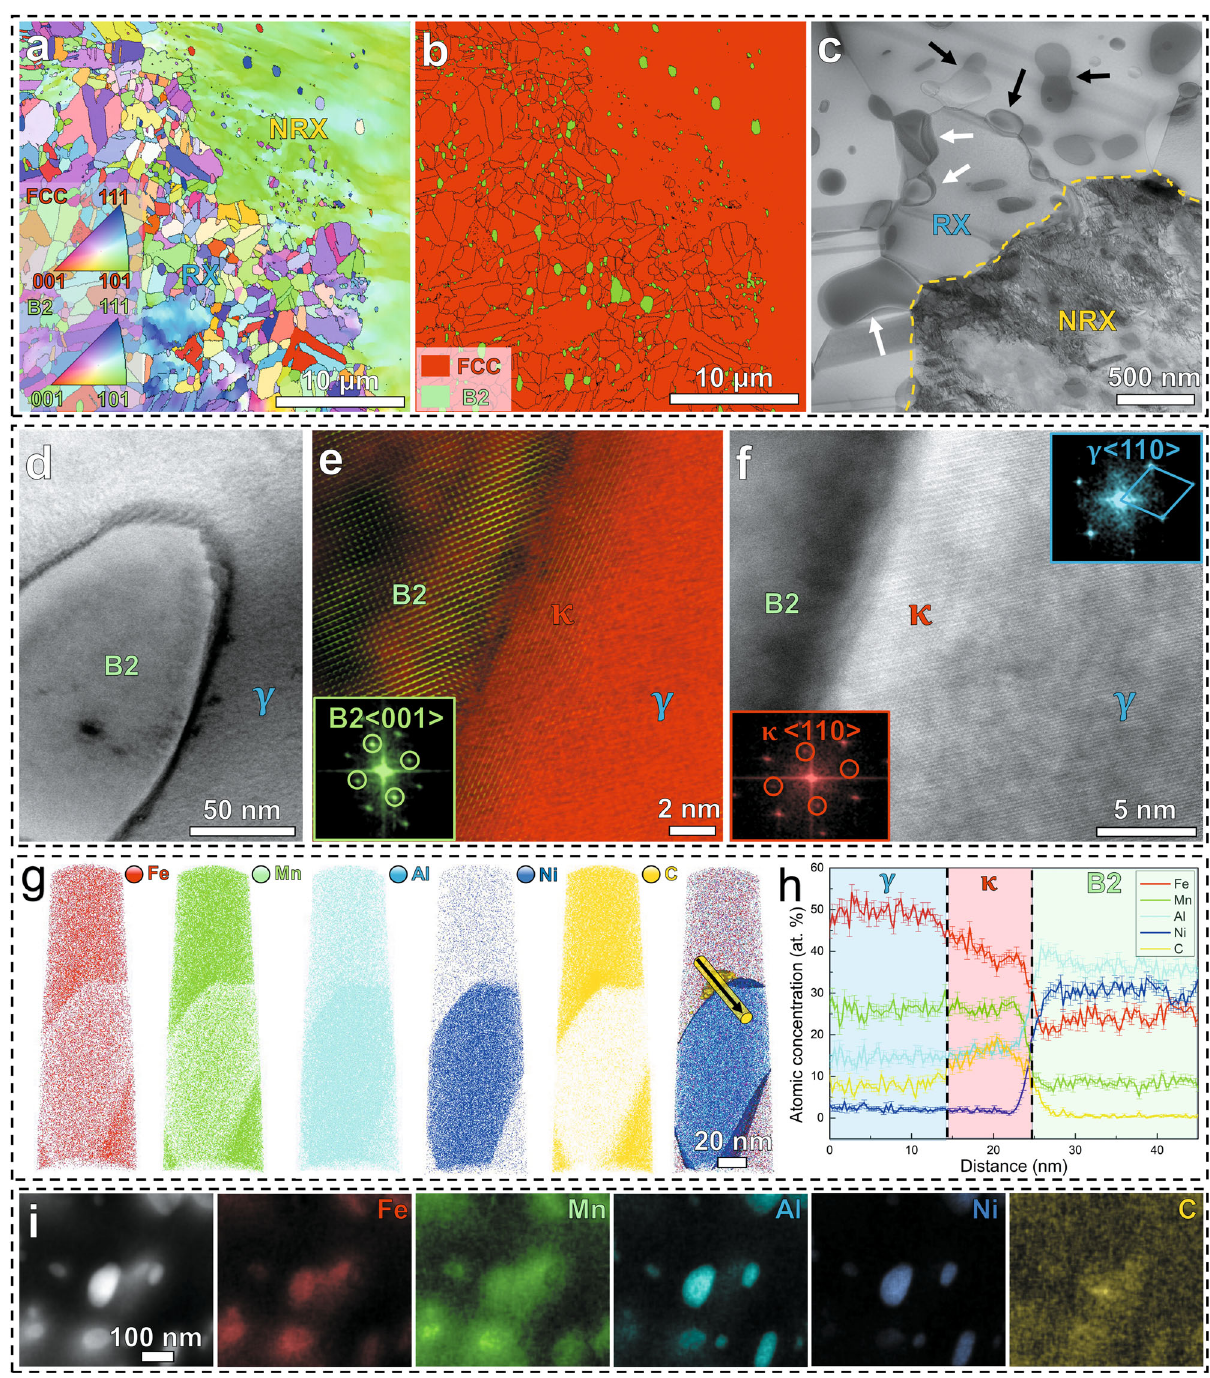
Fig. 1 Microstructures of the CCS. a EBSD IPF map. b EBSD phase map. c BF STEM image. The IPF map shows the existence of both, recrystallized (RX) and non-recrystallized (NRX) regions. The phase map indicates the formation of B2 precipitates in the austenite matrix, while the BF STEM image shows the formation of the other precipitate ( κ -carbide) together with B2 phase. Black lines in b indicate high angle grain boundaries. Black arrows and white arrows in c indicate two types of dual-nanoprecipitation. d ABF image and e , f corresponding Zoom-in images. The inserted FFT patterns con fi rm structures of B2, κ -carbide and γ matrix. g Atomic maps for individual elements and the one highlighted by iso-composition surfaces of 20 at. % Ni and 12 at. % C. h One-dimensional compositional pro fi les along the black arrow in g showing the chemical compositions of each phase. i HAADF STEM image and EDS maps showing the close contact of κ -carbide and B2 precipitates with similar sizes. IPF, BF, ABF, FFT, HAADF, and EDS refer to “ inverse pole fi gure ” , “ bright- fi eld ” , “ annular bright- fi eld ” , “ fast Fourier transform ” , “ high-angle annular dark- fi eld ” , and “ energy dispersive X-ray spectroscopy ” , respectively.